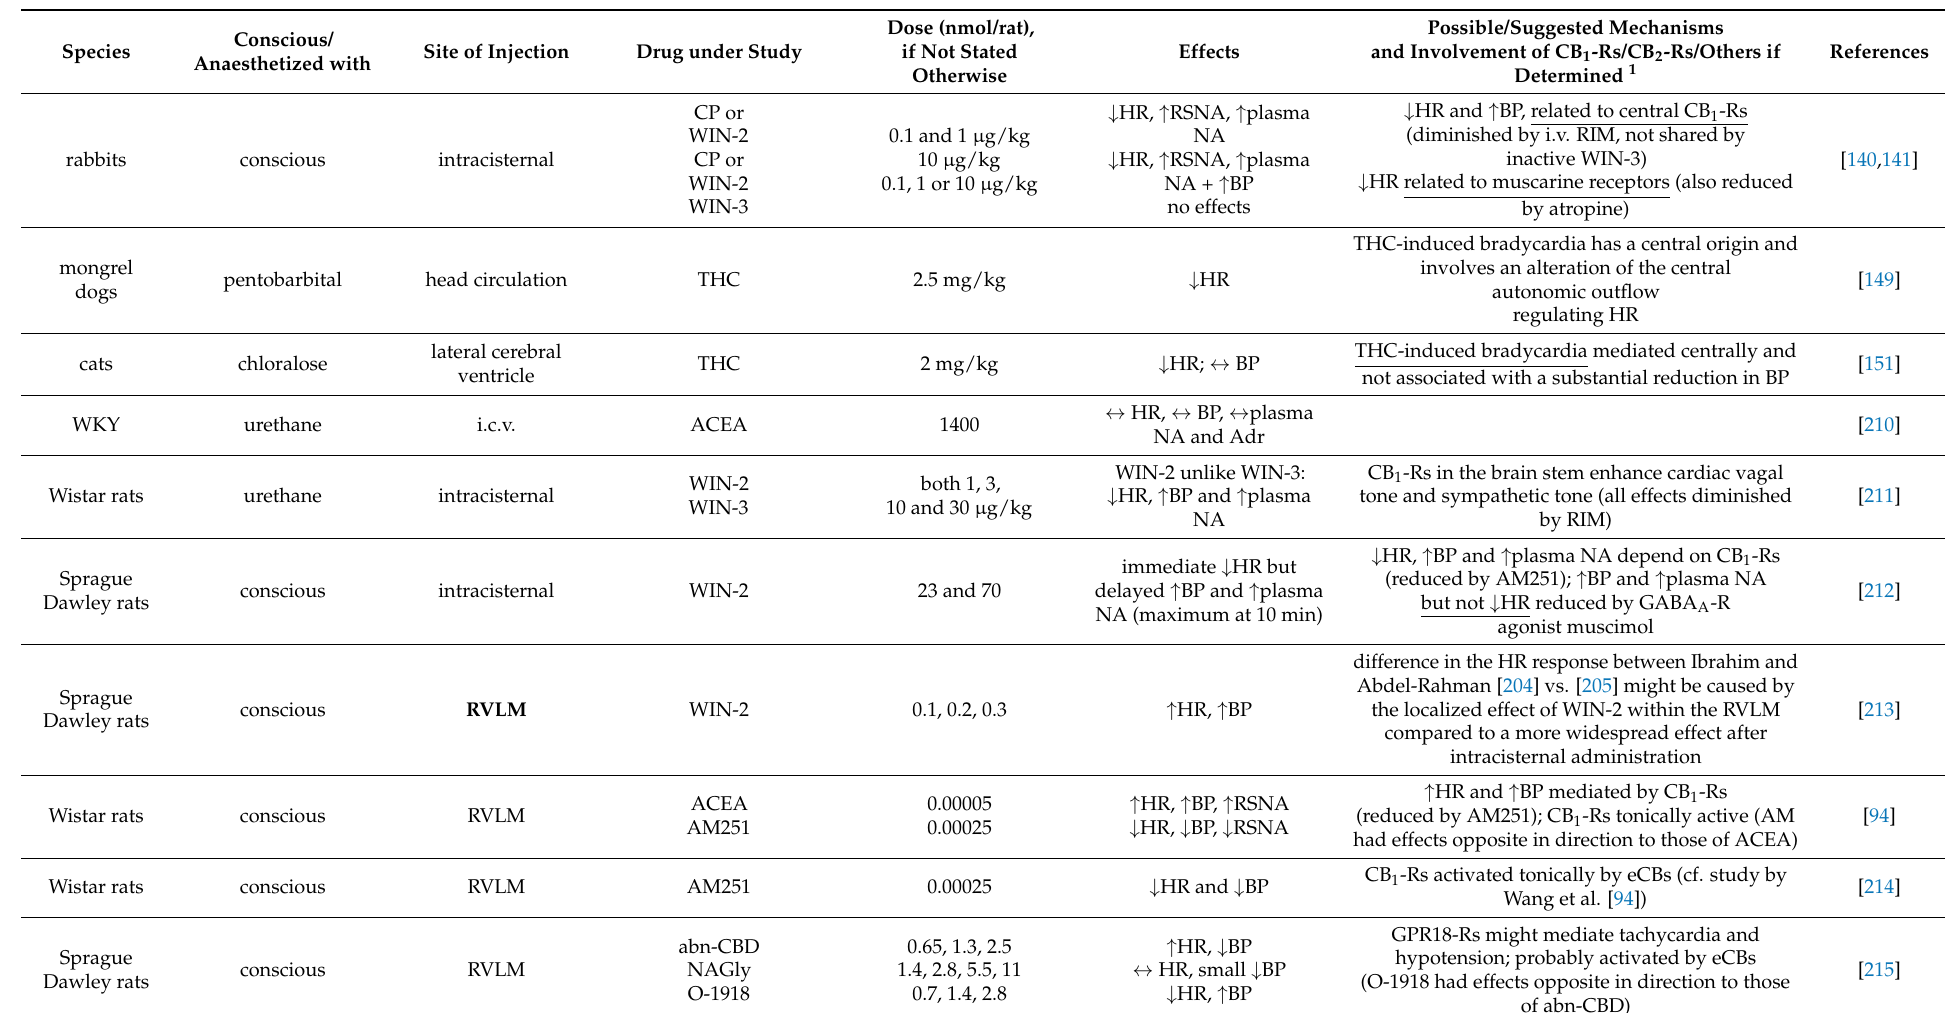
Table 5. Cardiovascular effects of acute cannabinoid administration into the cerebral circulation, the cerebrospinal fluid or directly into selected brain